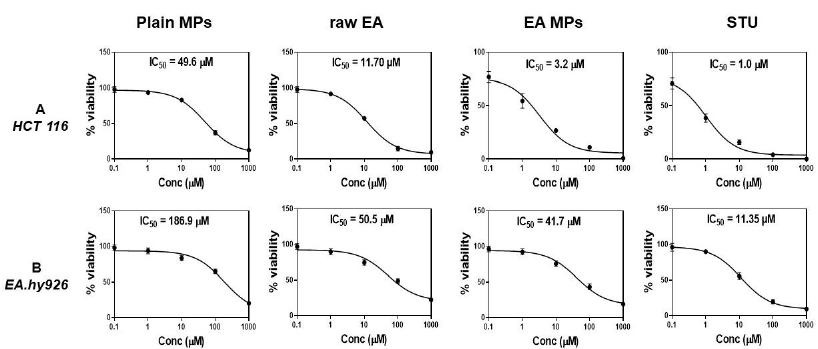
Figure 3. IC 50 of plain MPs, raw EA, and the EA MPs in ( A ) the HCT 116 cells and ( B ) EA.hy926 cells.